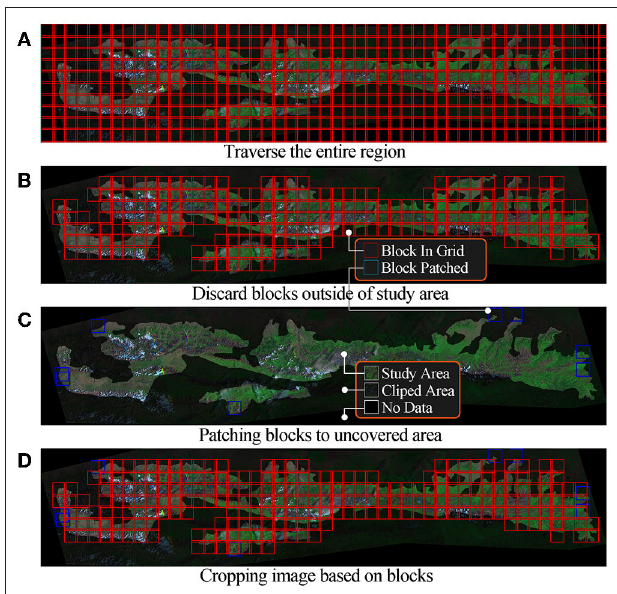
FIGURE 3 | Cropping remote sensing